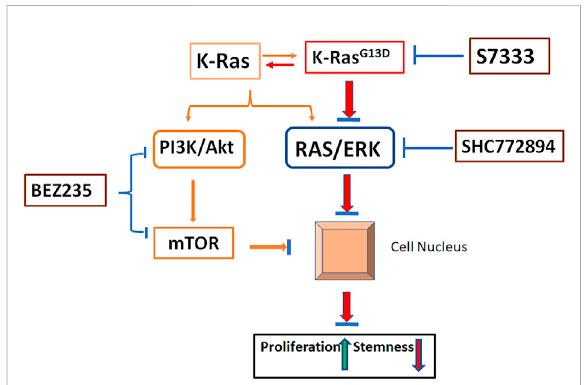
Schematic illustration of pathways involved in K-Ras G13D mutation. In the status of wild type, K-Ras activates both PI3K/Akt and RAS/ERK pathways and promote cancer cell growth while suppress stemness (orange lines). Upon mutation at K-Ras G13D , it mainly acts on RAS/ERK pathway to promote cell proliferation and reduce stemness by regulating gene expressions in the nucleus (Red lines). Inhibiting the mutation by S7333 will suppress RAS/ERK pathway (blue lines). Under the activation of K-Ras G13D mutation, the treatment of SCH772894 can more effectively suppress the RAS/ERK pathway thus cell proliferation and stemness in mutated but not wild type cells (blue lines). Differently,BEZ235treatmentcaninhibitcellgrowthandstemness in both mutated and un-mutated cells via PI3K/Akt and bypassing RAS/ERK pathway. After blocking K-Ras G13D mutation, the activating signal of RAS/ERK is reduced, the sensitivity to SCH772894 treatment in mutated cells